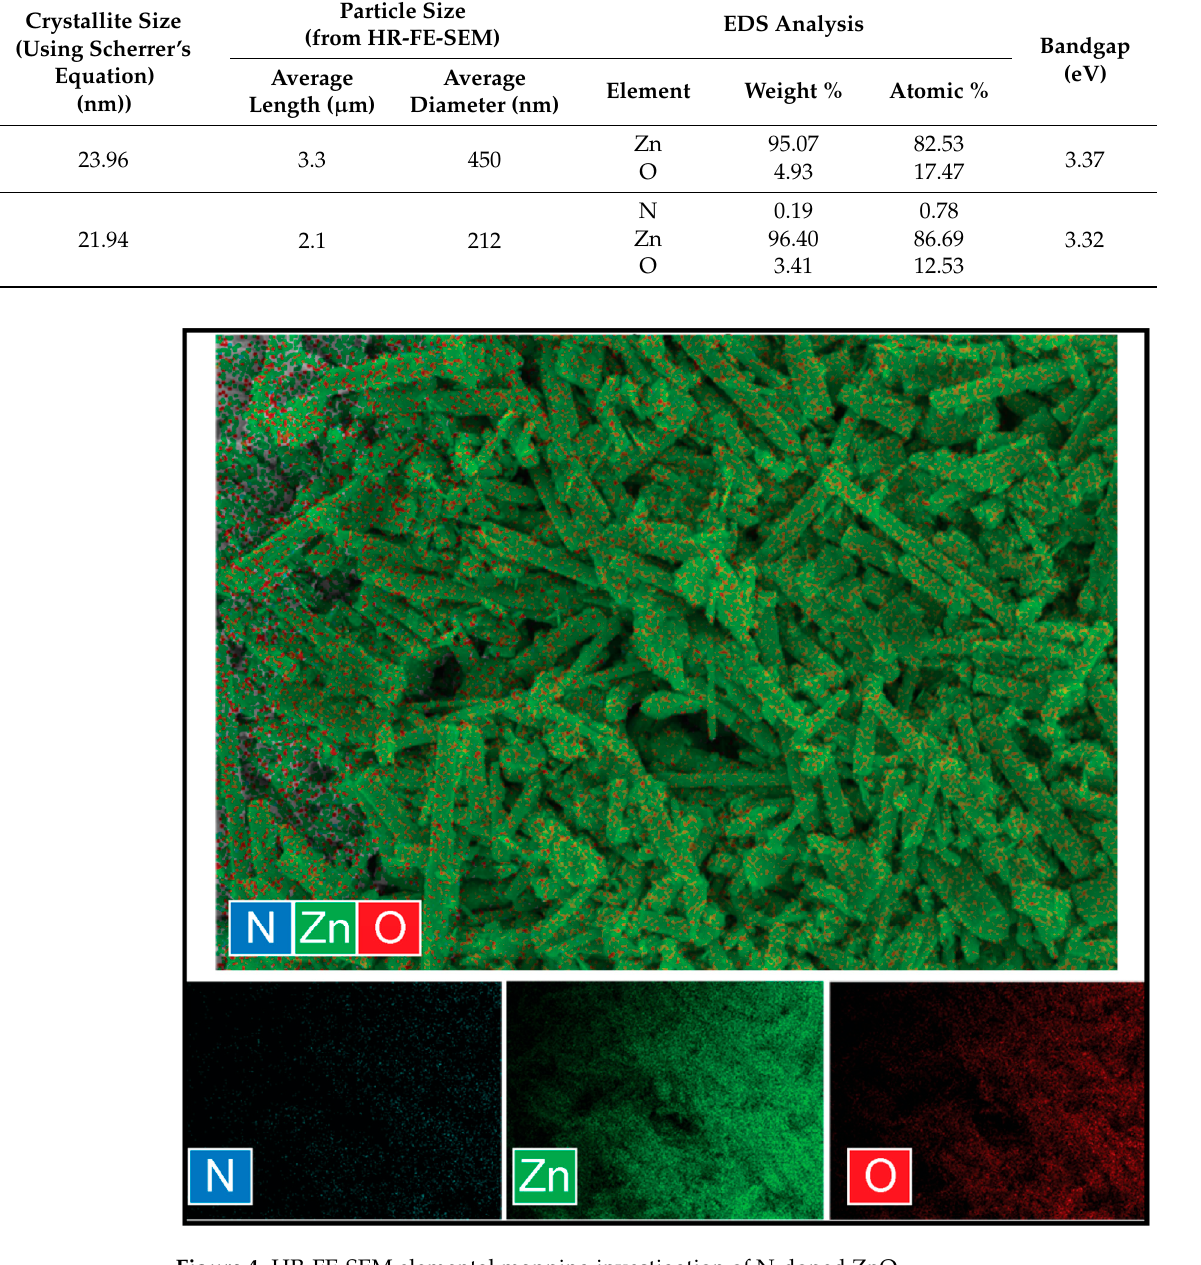
Figure 4. HR-FE-SEM elemental mapping investigation of N-doped